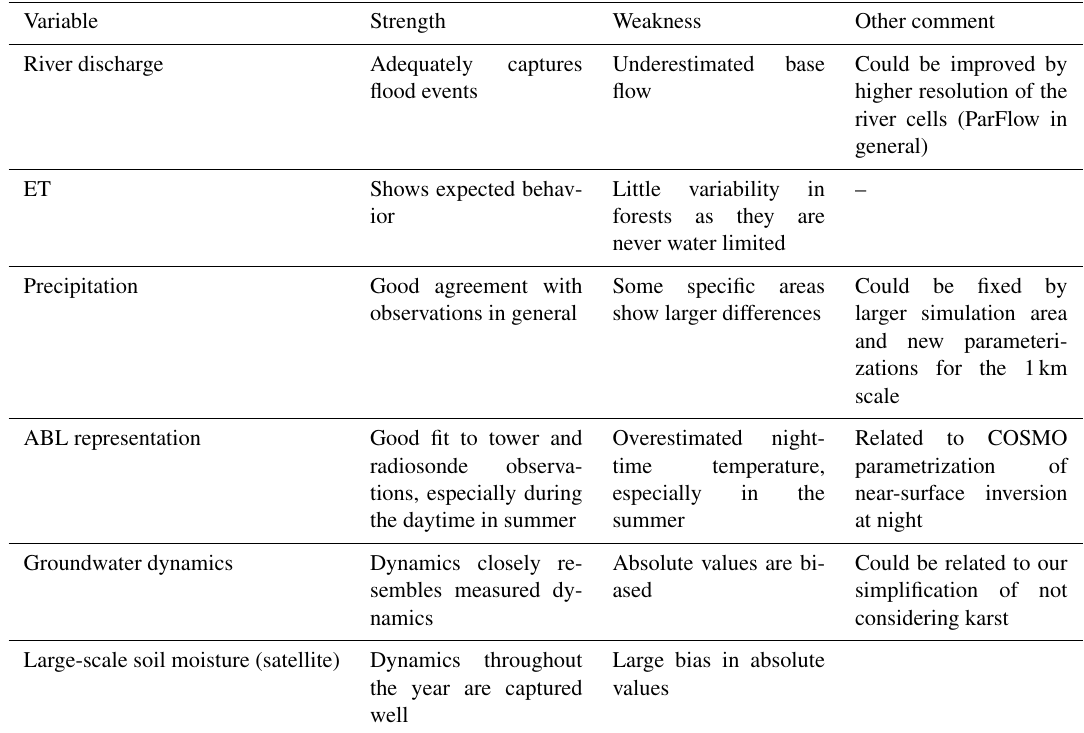
Table A3. Strengths and weaknesses of our simulation regarding several